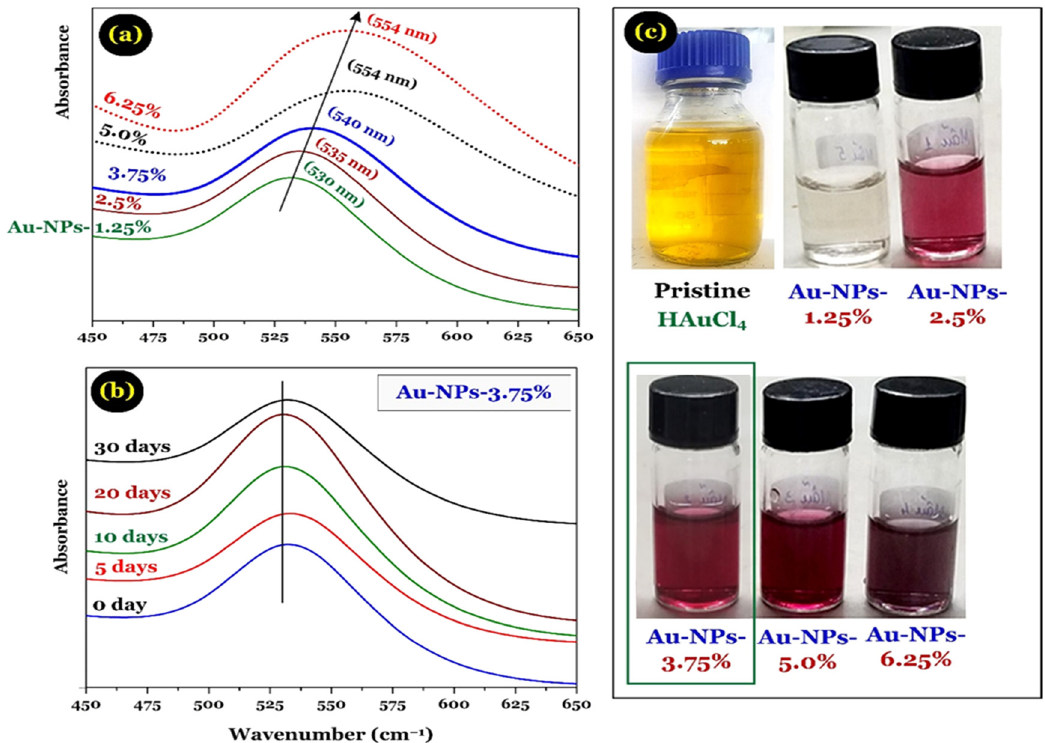
Figure 1: ( a ) UV - Visible spectra of the synthesized gold colloids, ( b ) its stability over times, and ( c ) manifestation of di ff erent colors of Au - NPs samples prepared from di ff erent ratios of the C. hindsii extract.